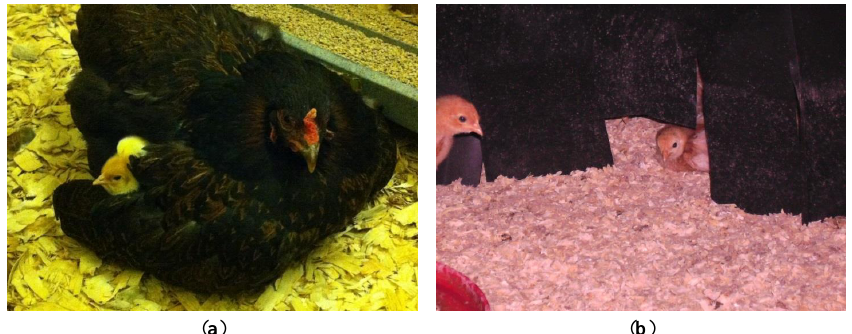
Figure 1. (a) Left: Mother hens provide an important source of warmth and darkness for chicks (Photo credit—J Edgar); ( b ) Right: Close up of the plastic fringed entrance to a dark brooder. their chicks (Photo credit – J Edgar); ( b ) Right: Close up of the plastic fringed entrance to a Dark brooders have been employed in a commercial setting to simulate the warmth and darkness of dark brooder. Dark brooders have been employed in a commercial setting to simulate the a broody hen (Photo credit—Anne-Marie warmth and darkness of a broody hen (Photo credit— Anne-Marie Gilani).